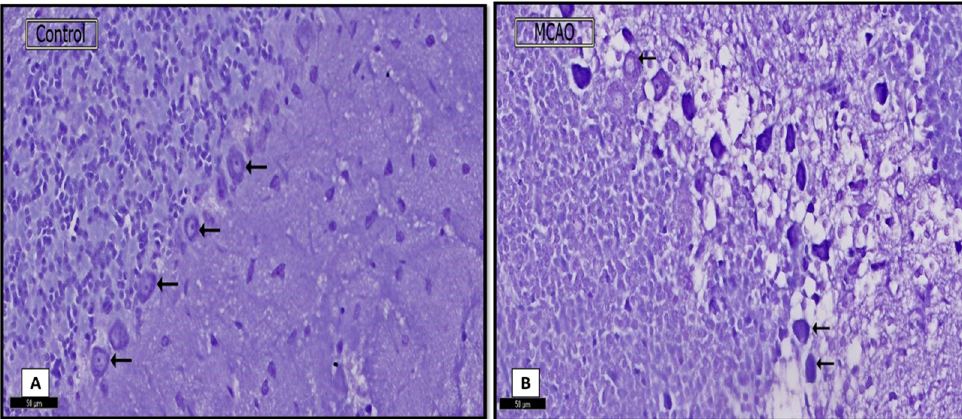
Figure 3. A Nissl-stained sections showing: ( A ) (control group) most of the Purkinje cells with Nissl’s granules ( ↑ ) in their cytoplasm. ( B ) (MCAO group) Some Purkinje cells with marked reduction of Nissl’s granules ( ↑ ) giving the faint cytoplasm appearance. (Nissl stain. × 20; Scale bar = 50 μ m).